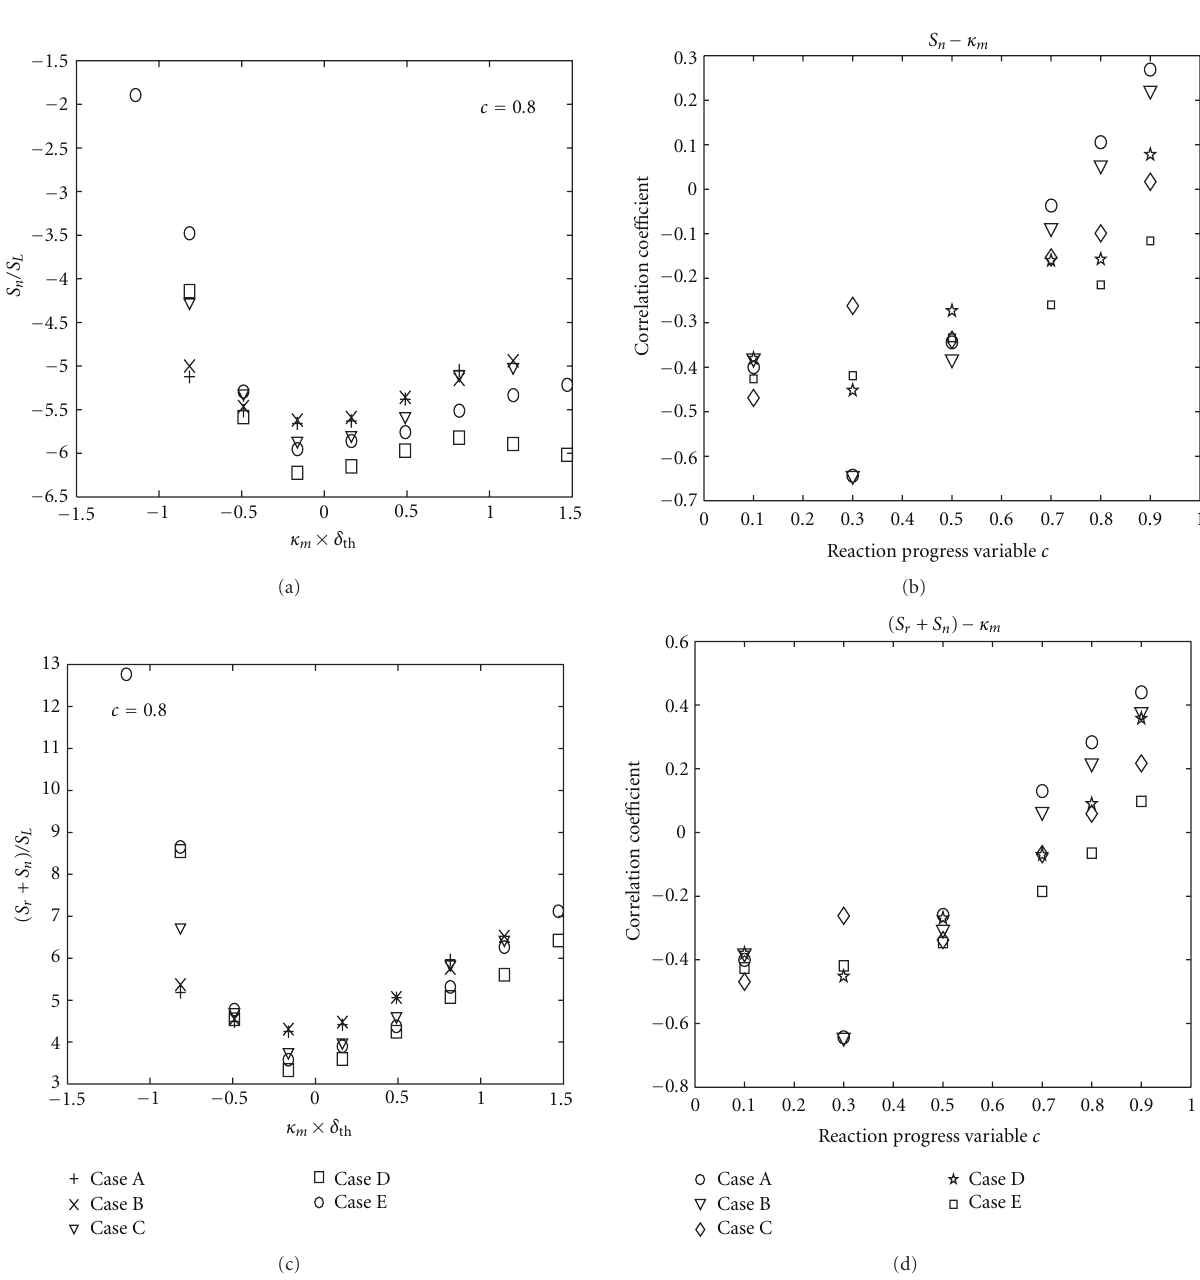
Figure 10: (a) Variation of mean values of S n /S L conditional on normalised curvature κ m × δ th for the isosurface at c = 0.8. (b) Variation of the correlation coe ffi cients between S n and κ m on the isosurfaces at c = 0.1 to 0.9 for all cases. (c) Variation of mean values of ( S r + S n ) /S L conditional on normalised curvature κ m × δ th for the isosurface at c = 0.8. (d) Variation of the correlation coe ffi cients between ( S r + S n ) and κ m on the isosurfaces at c = 0.1 to 0.9 for all